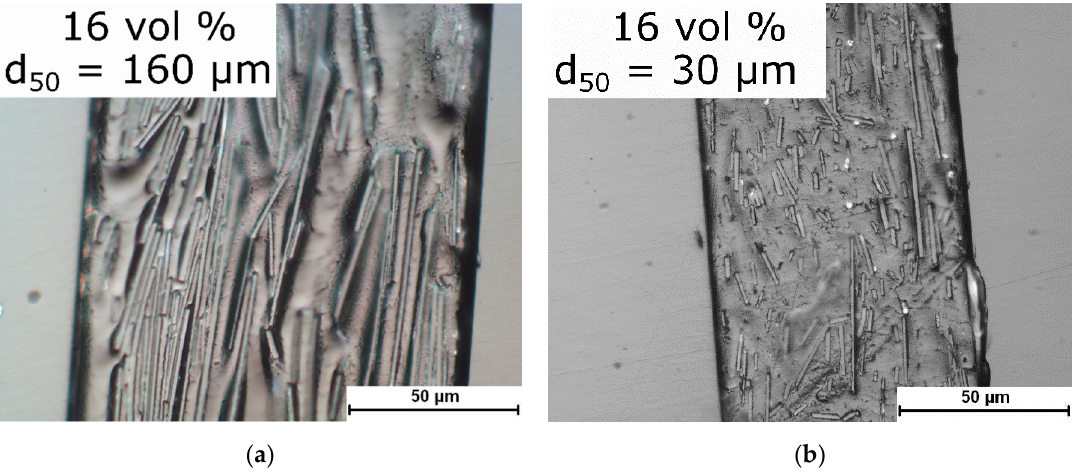
Figure 12. Cross-section of PVB–MGF composites with 16 vol % of GF100 ( d 50 = 160 µm) ( a ) and 16 vol % of GF001 (d 50 = 30 µm) ( b ) glass flakes.